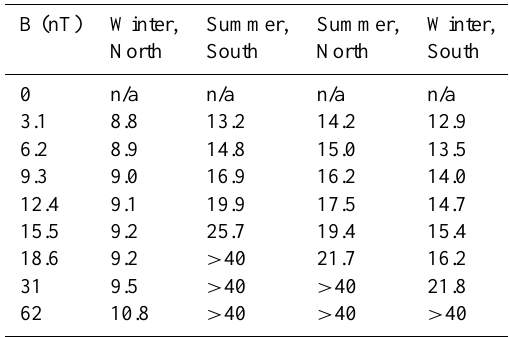
Fig. 9. Relation between tail field observed by GEOTAIL just be- fore the onset of substorms and the index A p for that day (Courtesy K. Shiokawa).